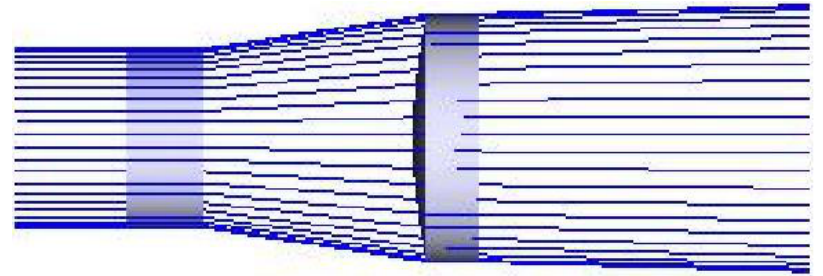
Figure 3. Galileo Beam-Shaping System.